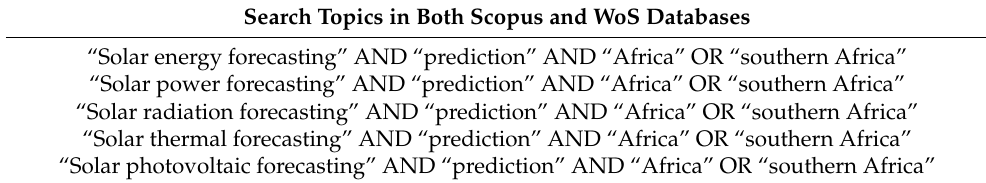
Table 1. The search topics used to retrieve energy-related documents published in Africa and southern Africa.